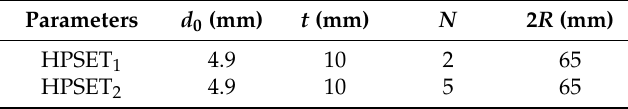
Table 2. Parameters of the tested samples of